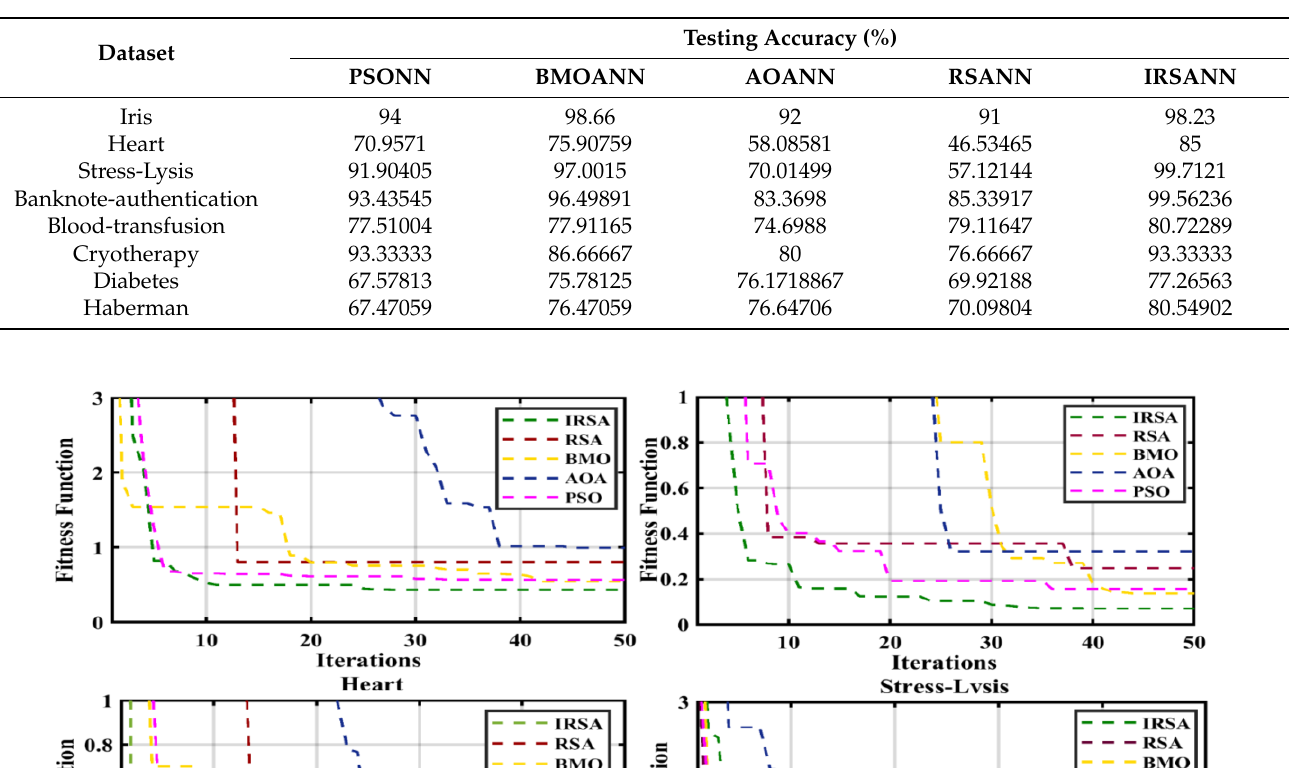
Table 8. Testing accuracy.